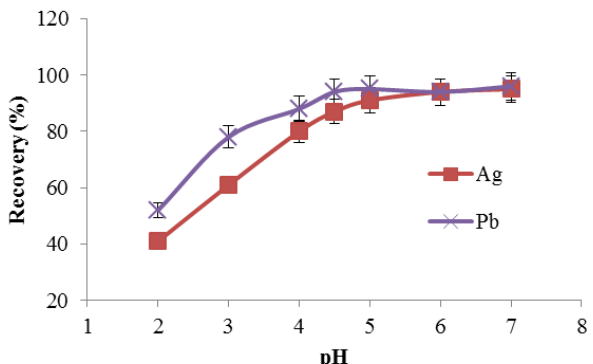
O NPs, Mn-Fe 3 4